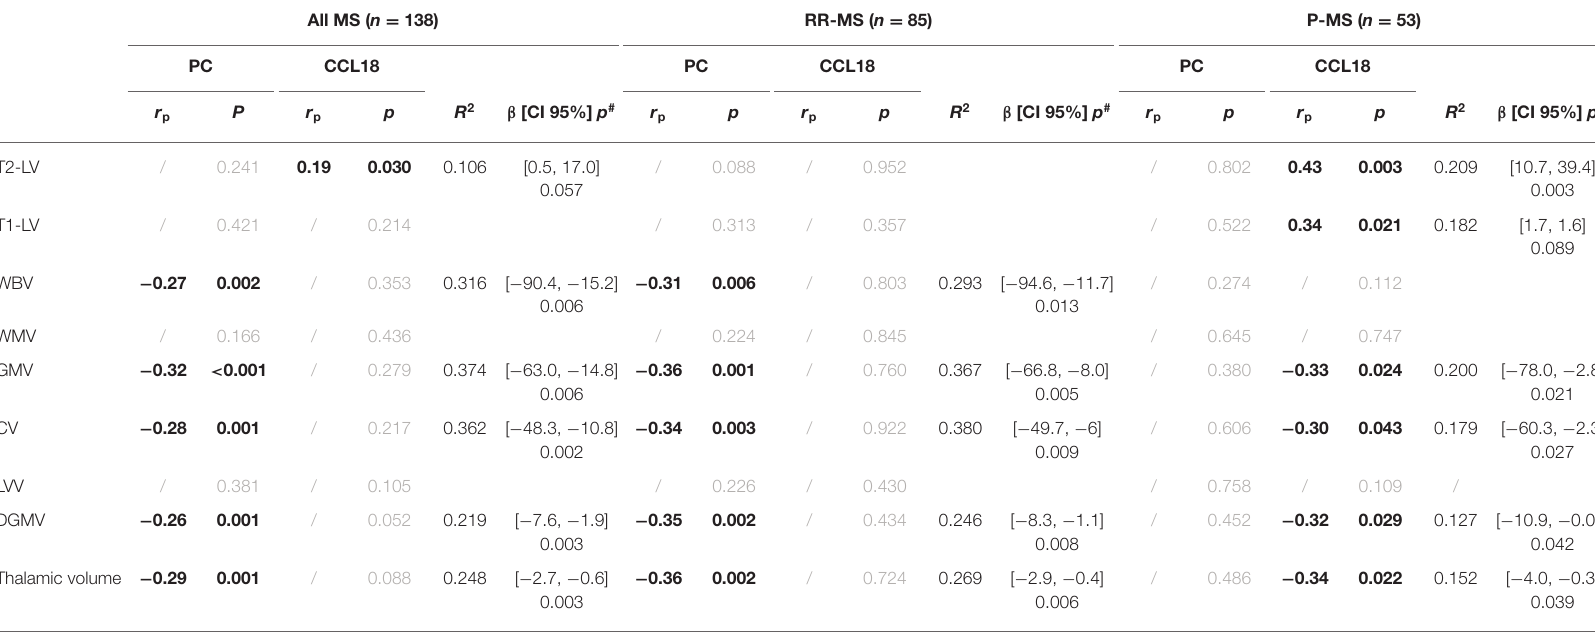
TABLE 3 | Association of PC and CCL18 concentrations with MRI characteristics in multiple sclerosis